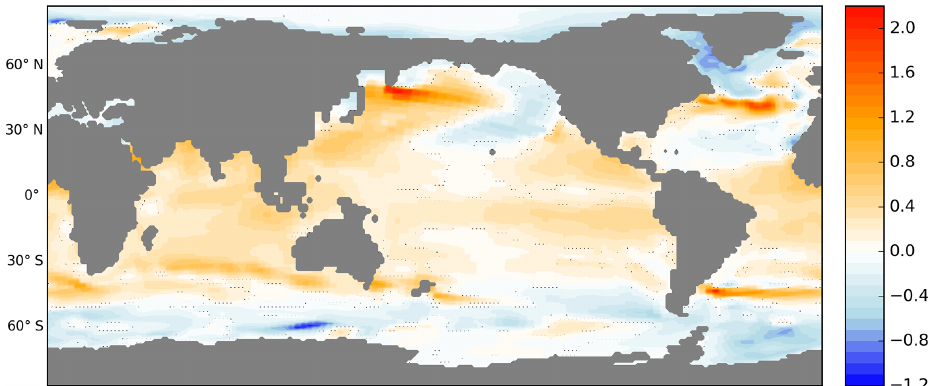
Figure 10. Annual mean SST anomalies due to a change in mid-Pliocene orbital forcing between Marine Isotope Stages K1 and KM5c, calculated from Eoi400_K1 −